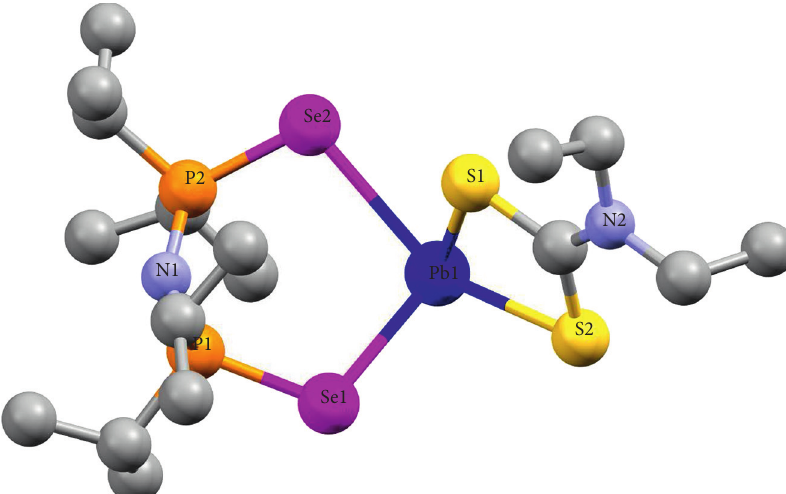
Figure 1: An ORTEP thermal ellipsoid structure of [Pb( i Pr Table 1: Crystal structure data for C Chem. formula